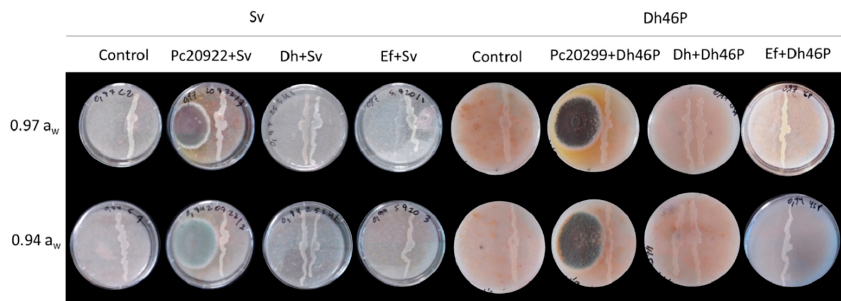
Figure 1. Interactions of three biocontrol agents ( Enterococcus faecium SE920, Debaryomyces hansenii FSHCC 253H, and Penicillium chrysogenum CECT 20922) with native dry-cured meat product microorganisms ( Staphylococcus vitulinus MSA19 and D. hansenii 46P) at 0.97 and 0.94 water activity ( a w ) after 7 days at 25 ◦ C in a dry-cured fermented sausage (salchich ó n)-based medium. Treatments: Control: native microorganism inoculated without biocontrol agents; Sv: S. vitulinus MSA19; Dh46P: D. hansenii 46P; Pc20299: P. chrysogenum CECT 20922; Dh: D. hansenii FSHCC 253H; Ef: E. faecium SE920. The biocontrol agent was inoculated on the left side of the plate and the tested microorganism on the right side of the plate.